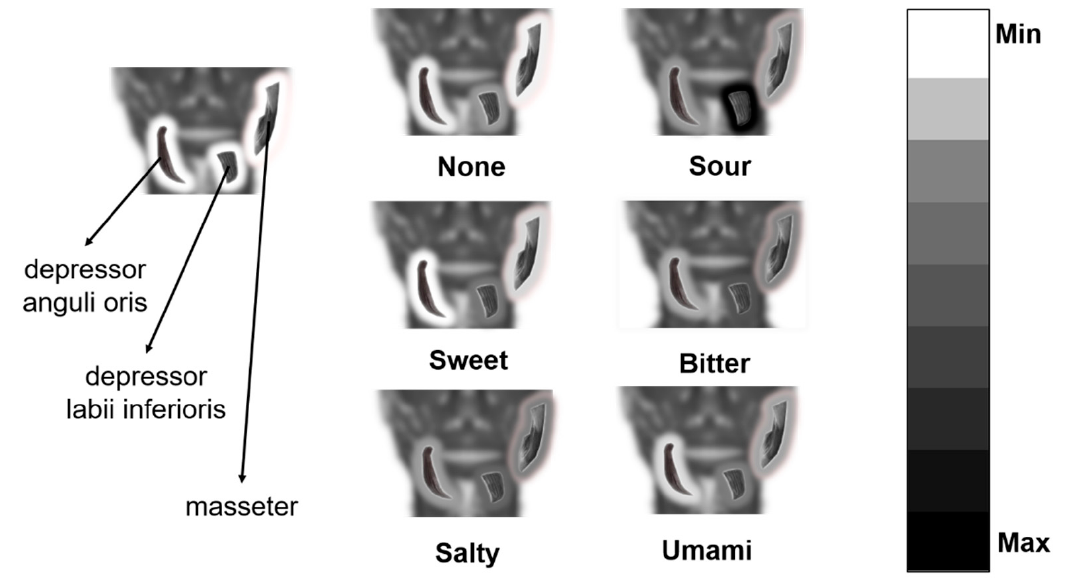
Figure 9. The activities of muscles under different taste stimuli. For depressor anguli oris, depressor labii inferioris, and the masseter, if the grayscale of the shadow around the muscle is smaller (the color is closer to the black) it represented the activity of the muscle is stronger under corresponding taste stimuli.